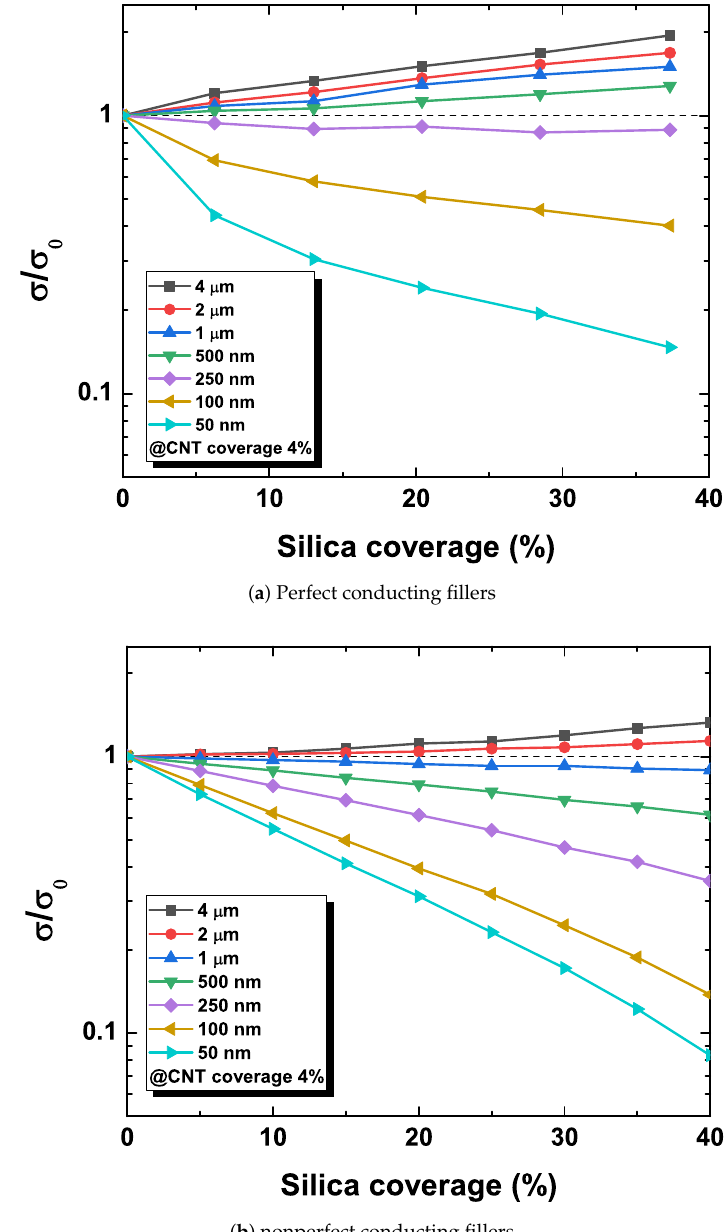
Figure 3. Normalized conductance changes for perfect and nonperfect conducting fillers with respect to silica